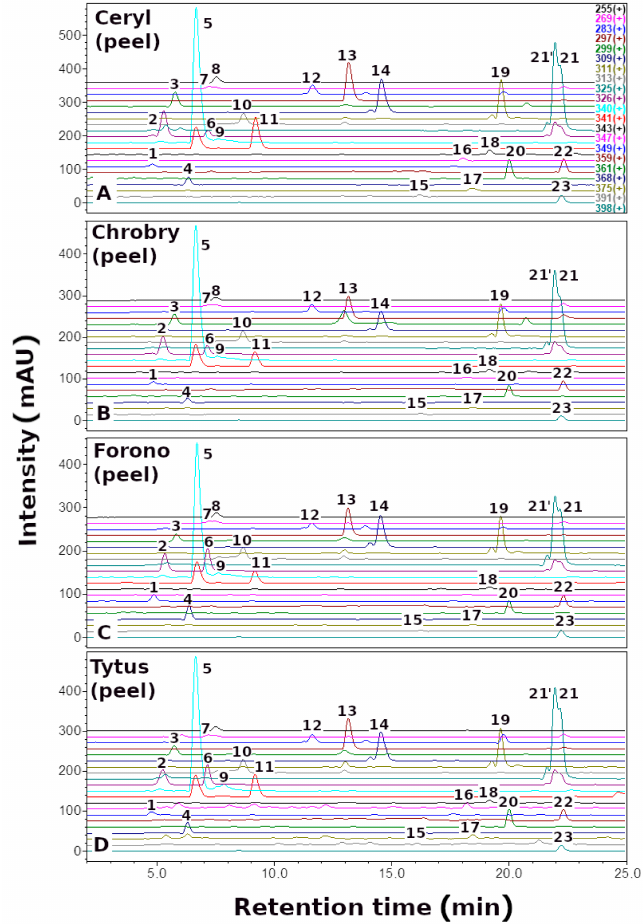
Figure 3. Selected-ion monitoring chromatogram (ESI-MS) in positive ion mode for betaxanthins of red Beta vulgaris L. peels: ( A ) Ceryl, ( B ) Chrobry, ( C ) Forono, and ( D ) Tytus. Numbers and names are available in Table